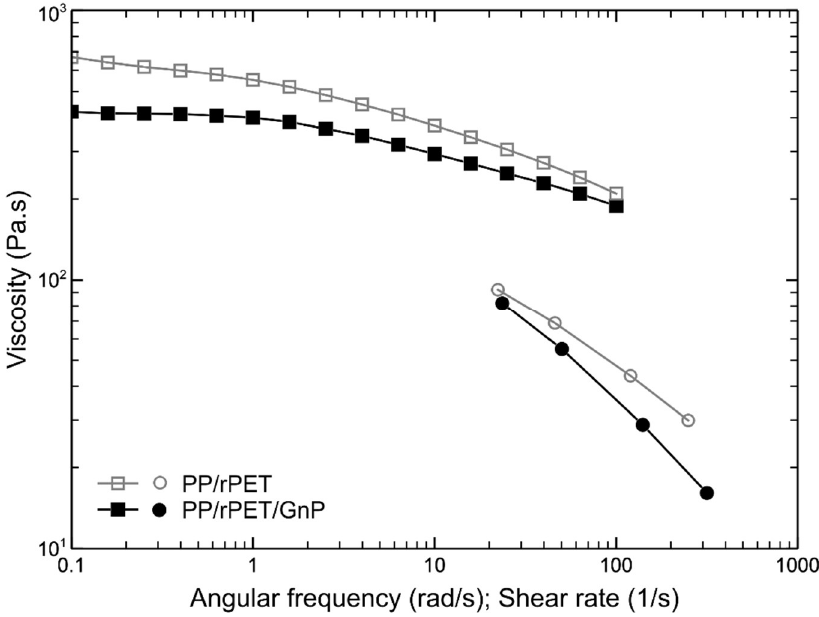
Figure 2. Flow curves of the two systems: data taken from rotational rheometer (square symbols) and capillary viscometer (circle symbols).